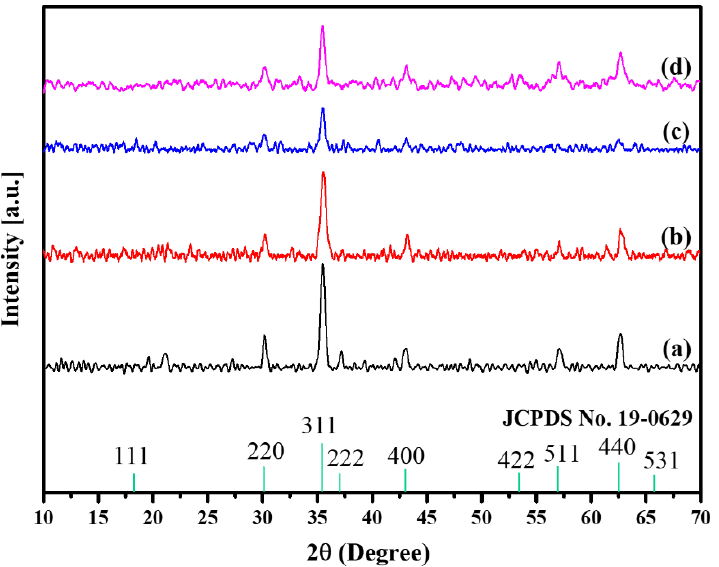
Figure 2. X-ray diffraction patterns of ( a ) Fe 3 O 4 NPs; ( b ) Fe 3 O 4 @C-T 190 t 3; ( c ) Fe 3 O 4 @C-T 190 t 4 ; ( d ) Fe 3 O 4 @C-T 190 t 5